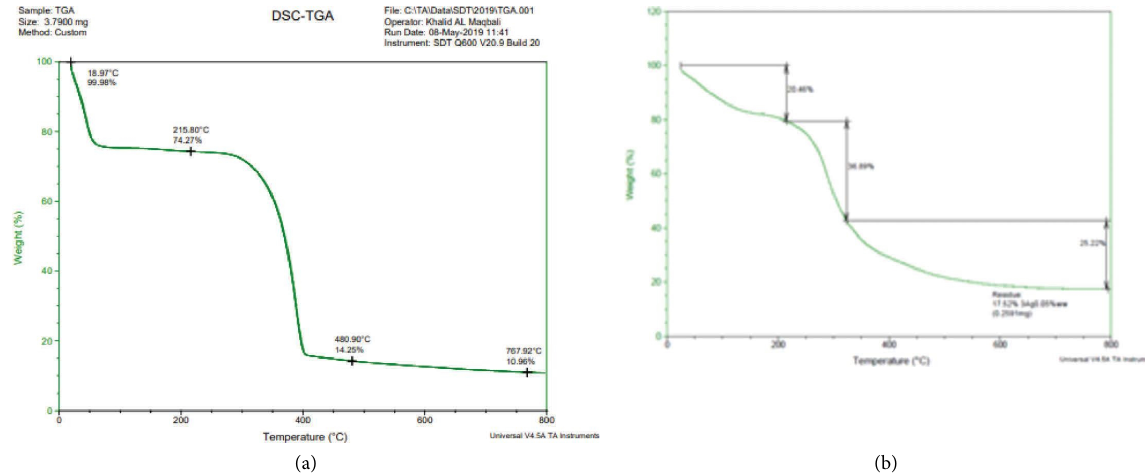
Figure 5: (a) TGA of prepared chitosan. (b) TGA of standard chitosan